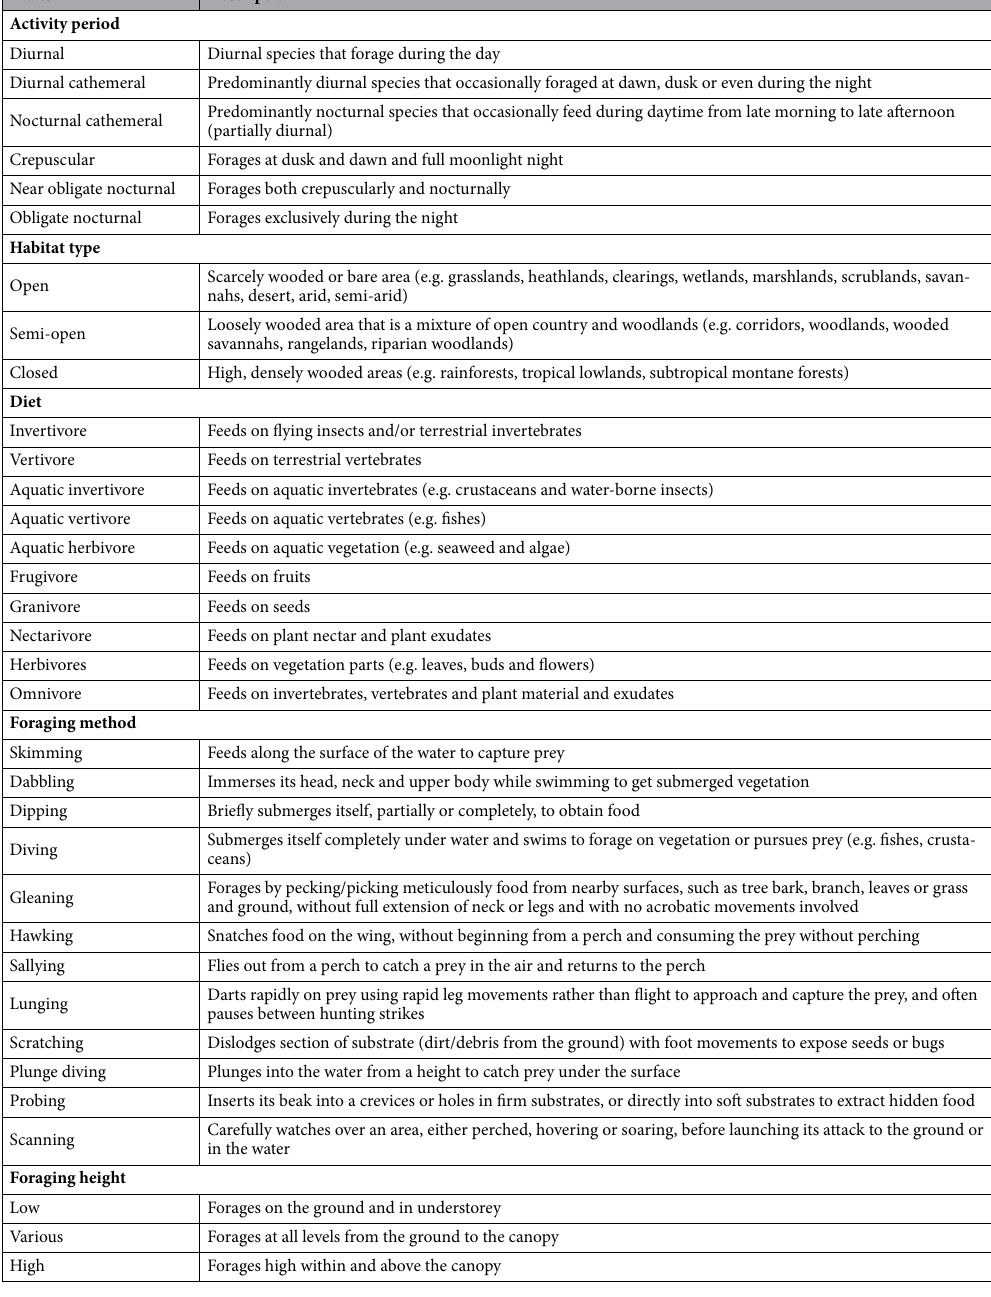
Table 3. Ecological traits used in this study with their definitions and